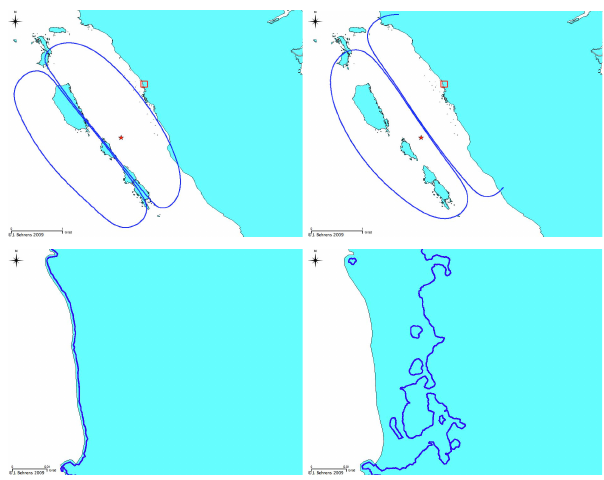
Fig. 1. Top: two hypothetical tsunami sources corresponding to the same magnitude ( M w =8.5) and epicenter shown by a star. The centroid of the scenario on the left lies some 50km further west. Bottom: inundation area corresponding to the two different source models off Padang (zoomed area depicted as square in upper panels) showing that inundation in the near-field case sensitively depends on details of the slip